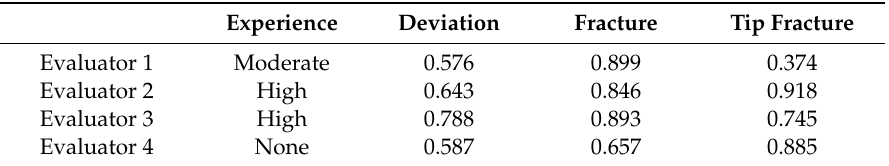
Table 2. Alpha values for the intra-reliability of four evaluators (and experience level) indicating agreement between the first and second rounds of palpation for keel bone deviations, fractures, and tip